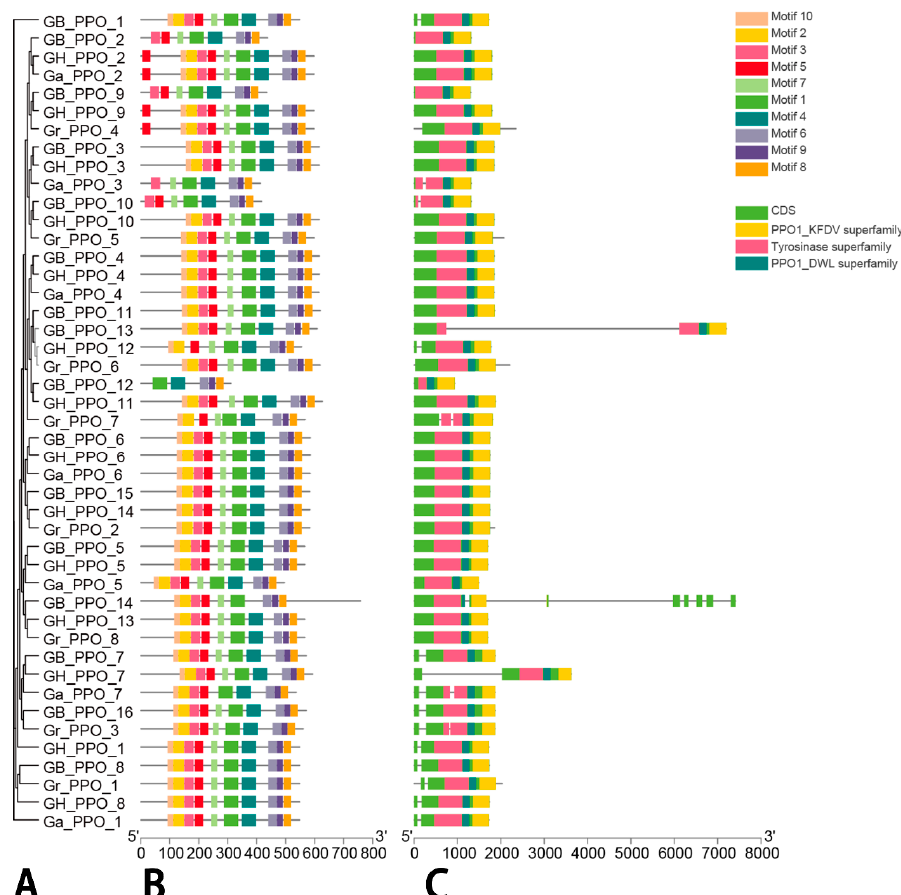
Figure 3. Analyses of evolutionary relationship, conserved motif, and gene structure of PPO family in cotton. Note: ( A ) represents the evolutionary tree of cotton PPO genes, ( B ) represents the conserved motif of cotton PPO genes, and ( C ) represents the gene structure of exon and intron of cotton PPOs. The scale axis of ( B , C ) indicate the sequence length.